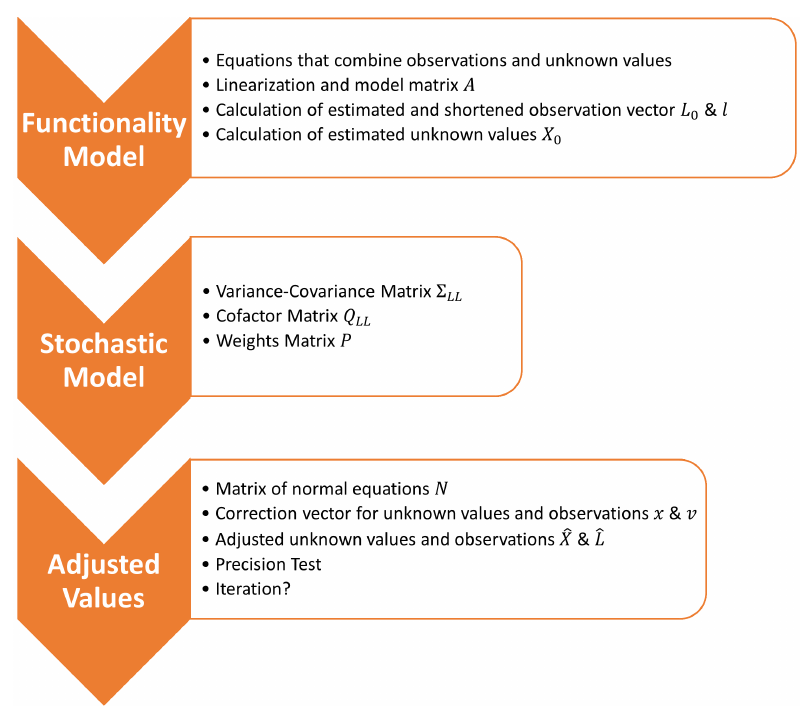
Figure 7. Flowchart of weighted least squares